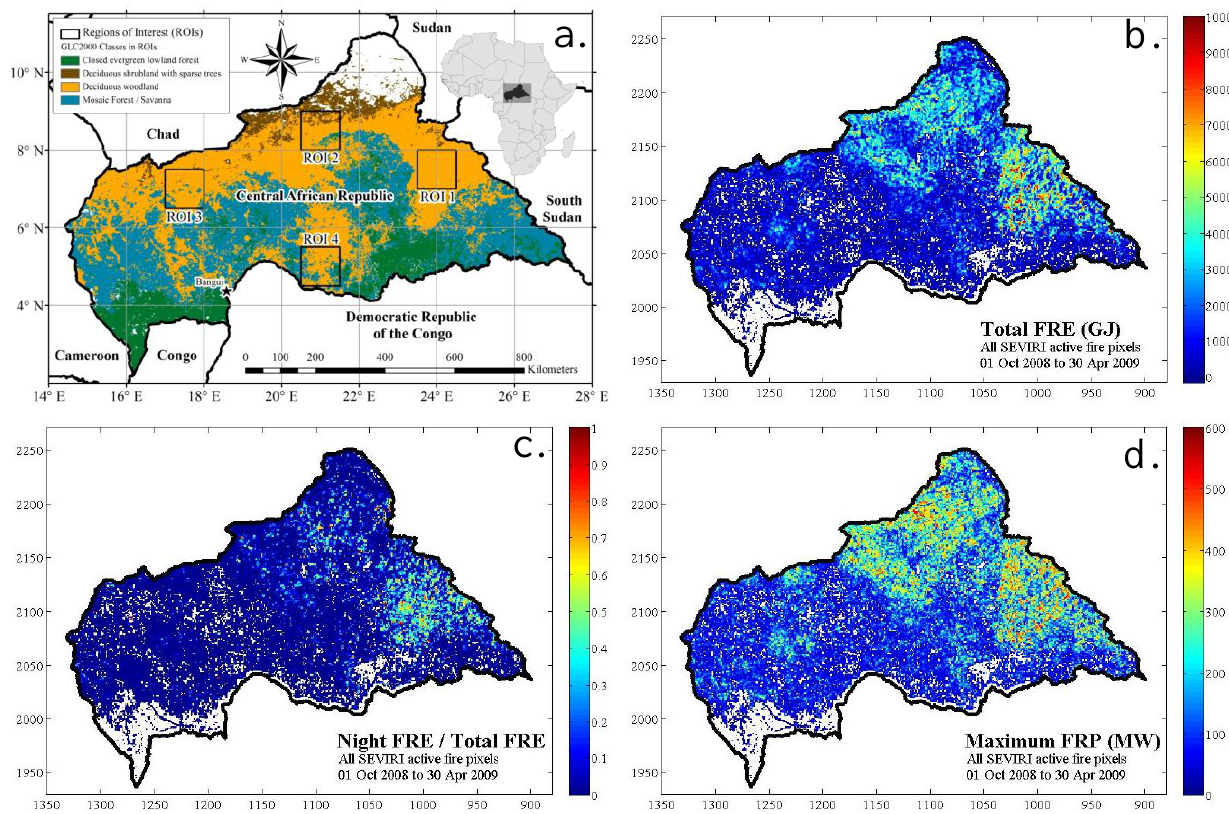
Figure 1. Map of the Central African Republic (CAR) illustrating ( a ) the four regions of interest (ROIs) used herein and the GLC2000 landcover classes found within the ROIs. The geographical gradient of fire activity across the CAR is highlighted using the seasonal FRE measured by SEVIRI ( b ); the nighttime-to-daytime ratio of the FRE measured by SEVIRI ( c ); and ( d ) the maximum FRP measured by SEVIRI. Maps (b–d) were derived from all SEVIRI active fire pixels recorded in the operational FRP-PIXEL product between 1 October 2008 and 30 April 2009, and are presented in the native SEVIRI image coordinate